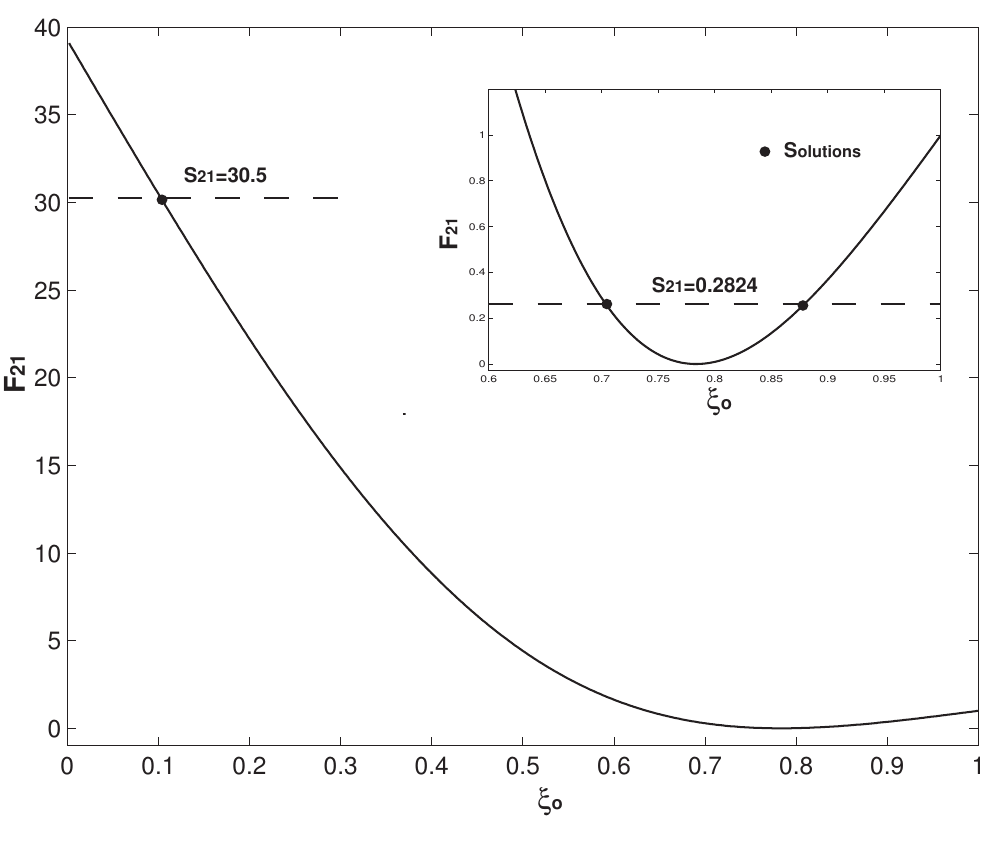
Figure 3. F solutions when S